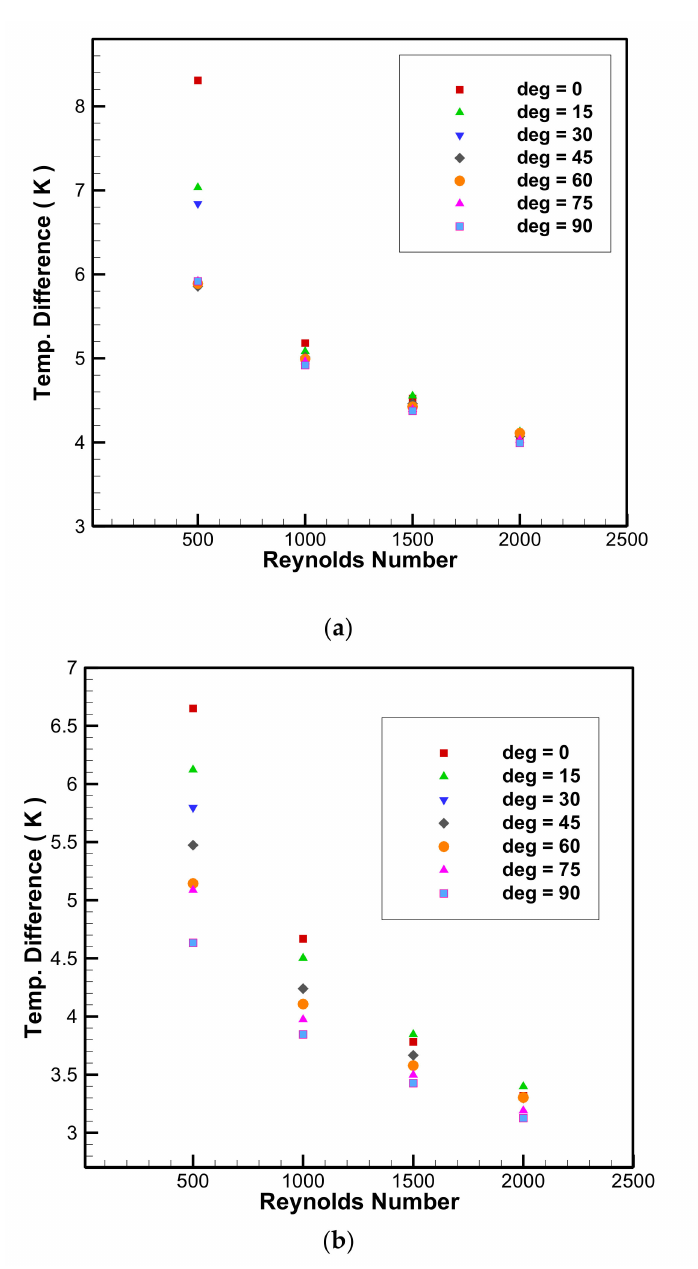
Figure 6. Temperature di ff erence in the permeate channel at ( a ) the hot wall and ( b ) the cold